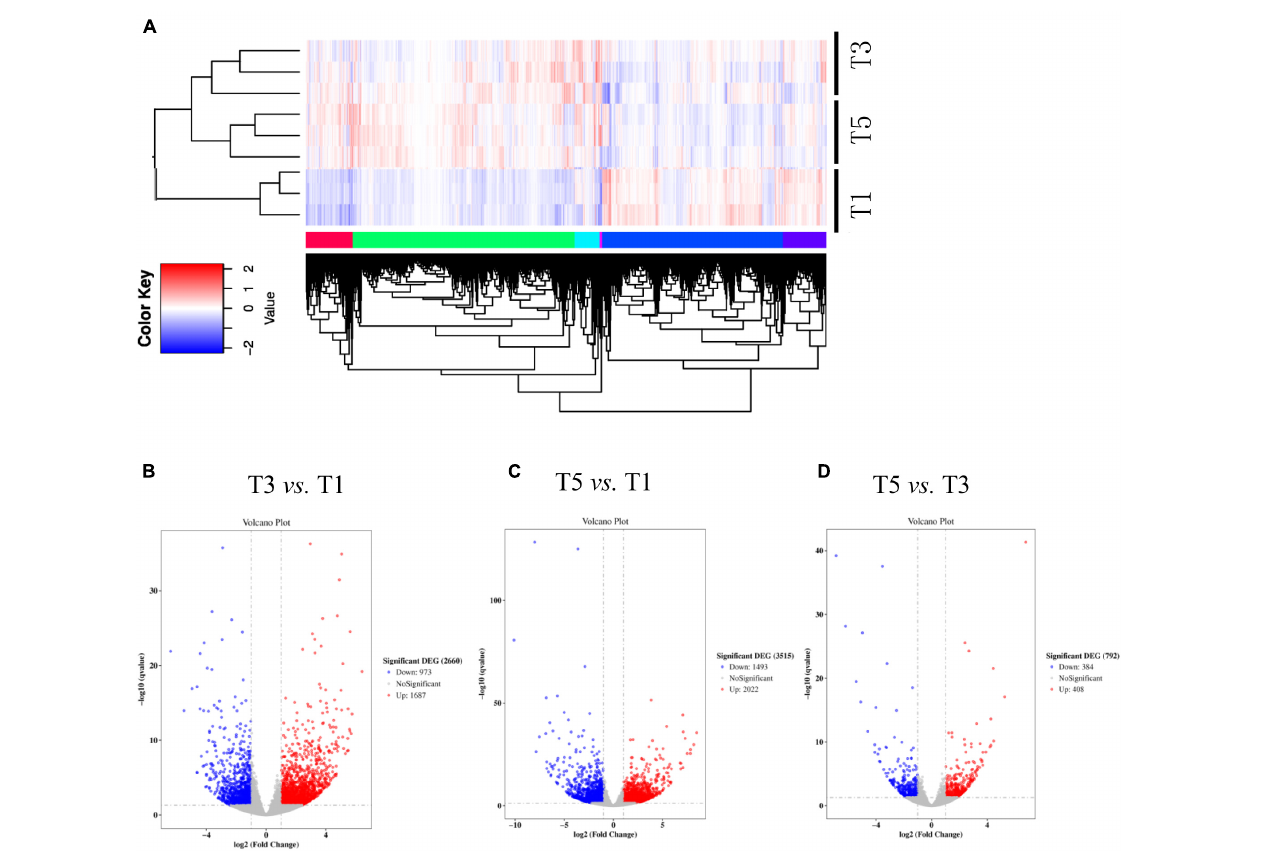
FIGURE 4 | Numbers of differentially expressed genes (DEGs) in sugar beet’s root in response to (A) 3 years of continuous cropping (T3), (B) 5 years of continuous cropping (T5), and (C) the comparative DEGs between T3 and T5. (D) Heatmap shows the profiling of DEGs between T1, T3, and T5. TABLE 5 | Top overrepresented GO groups for the comparison of groups T1 vs. T3, T1 vs. T5, and T3 vs. T5. Comparison between